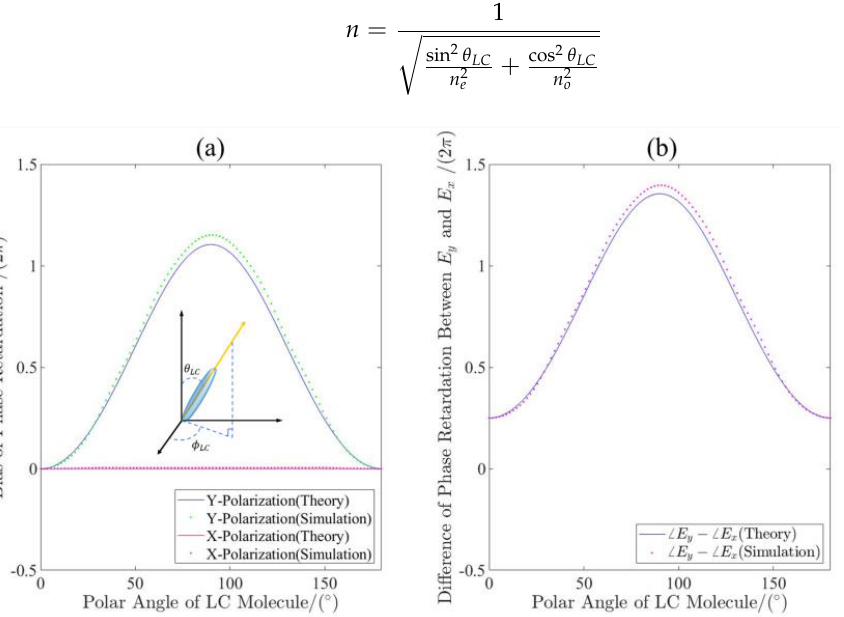
Figure 4. The phase retardation control of the NLC cell. ( a ) Theoretical and simulated phase retardation as functions of the polar angle of LC molecules for different incidence; ( b ) theoretical and simulated difference of phase retardation between x- and y-component of the transmitted light for LCP incidence functioning as the polar angle of LC molecule.